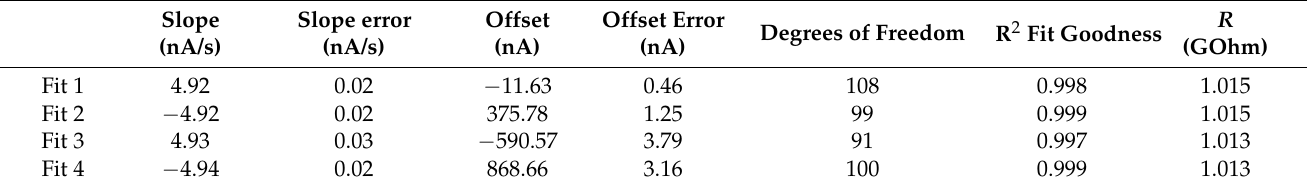
Figure 5. VRM method applied to a circuit with a standard 8.2 nF capacitor in parallel to 1 GOhm resistor; two VRM cycles were applied: ( a ) schematic of the measurement setup; ( b ) current intensity output vs. time as measured by the picoammeter (blue points) and linear fit regression (red line). Table 1. Fit results of a linear regression to the four ramps of the current VRM output of Figure